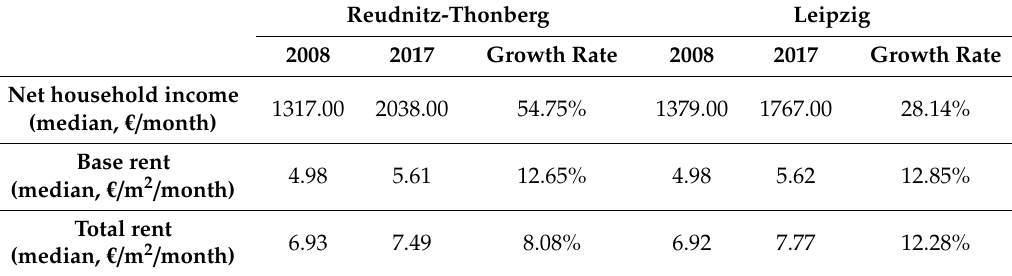
Table 2. Income and rent development in Reudnitz-Thonberg and Leipzig (Data sources: [86]).